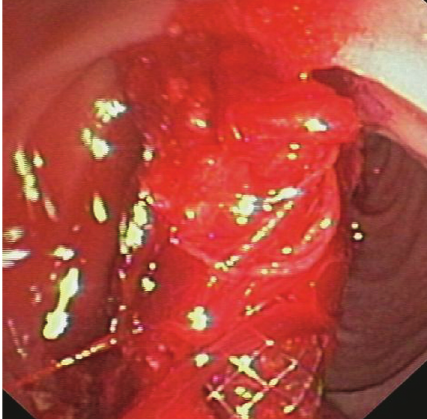
Figure 8: Expandable covered metallic stent placement.